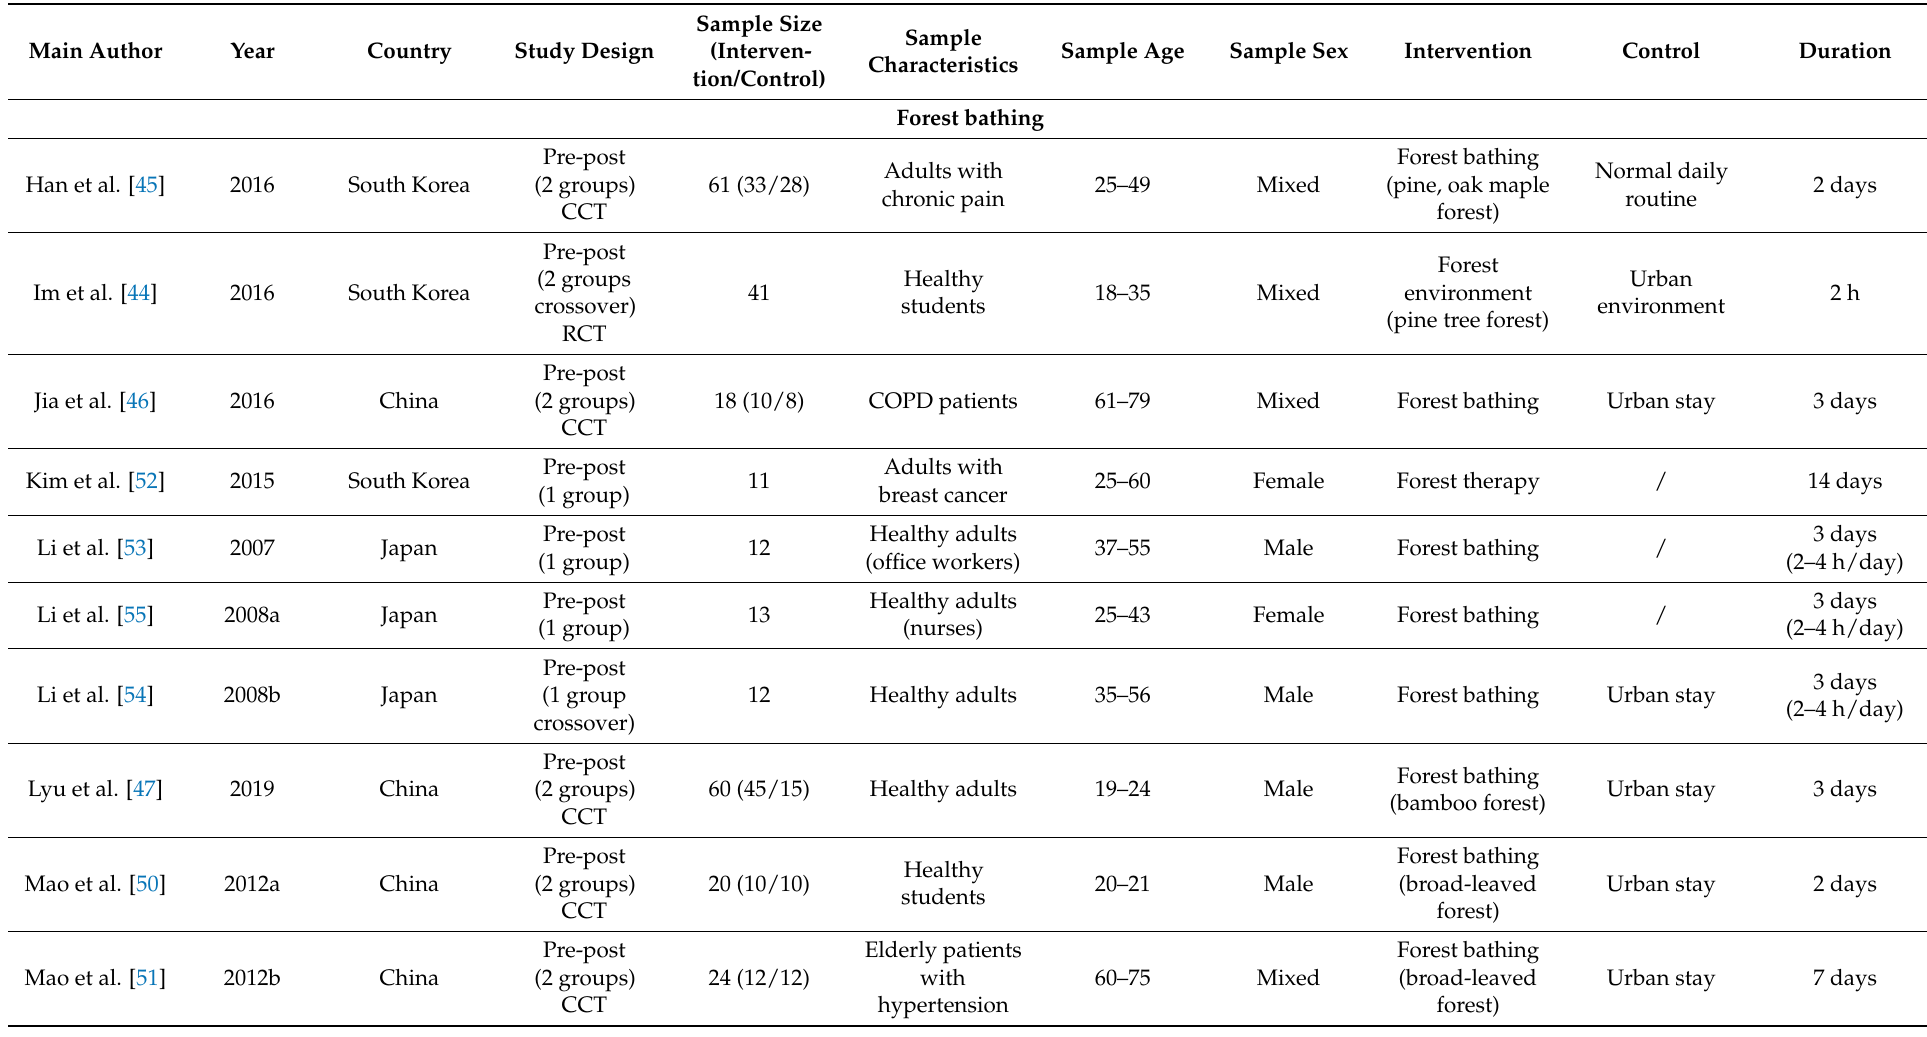
Table 1. Characteristics of included human